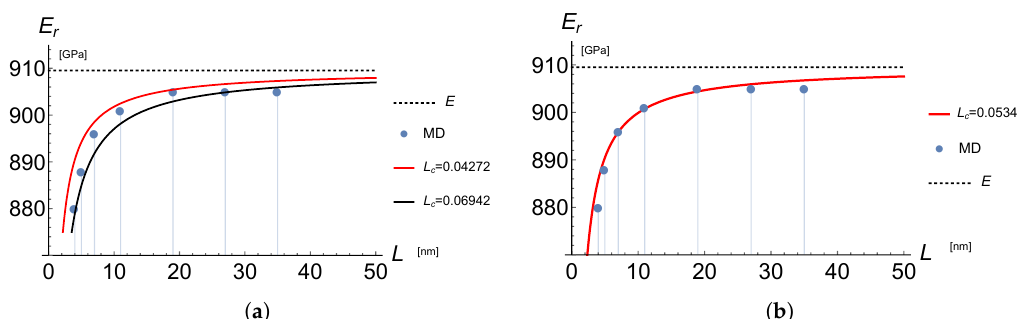
Figure 4. SWCNT of armchair (10, 10) having diameter d = 1.356 nm , effective thickness t = 0.34 nm and classical (local) Young’s modulus E = 909.5 GPa simulated by a CF nano-rod with a concentrated load at the free end. ( a ) Plot the variation of the Young’s modulus obtained by the NSG method together with the MD data versus the SWCNT length. The upper bound is given for the nonlocal parameter L c = 0.04272 nm and the lower bound is given for the nonlocal parameter L c = 0.06942 nm. ( b ) Variation of the Young’s modulus obtained by the NSG model and the MD data for the nonlocal parameter L c = 0.0534 nm.